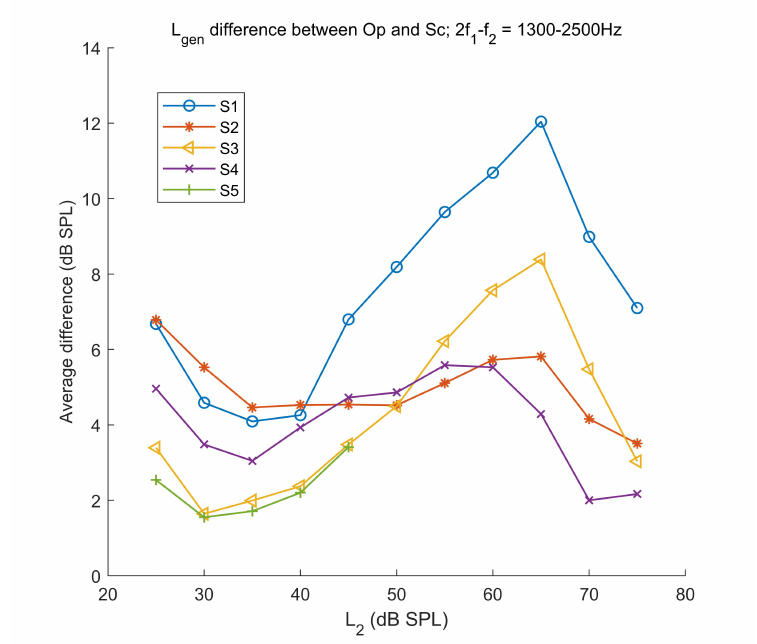
Figure 3. Average L gen difference between the Op and Sc paradigms across L 2 at the frequency range of 1300–2500 Hz for different subjects (shown in the legend).